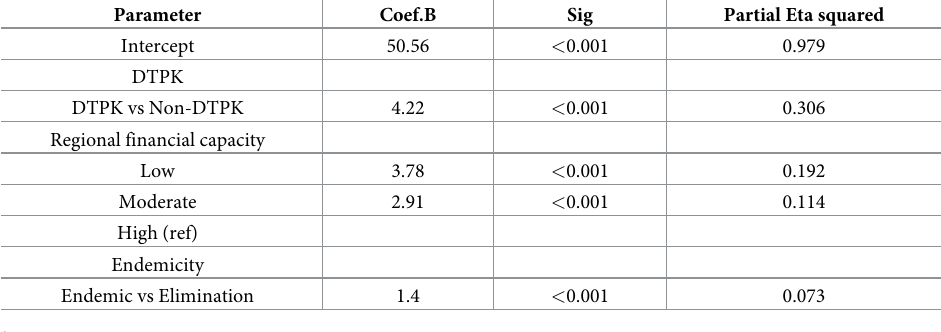
Table 4. Results of ANCOVA multivariate analysis on the readiness of malaria surveillance information systems at primary health